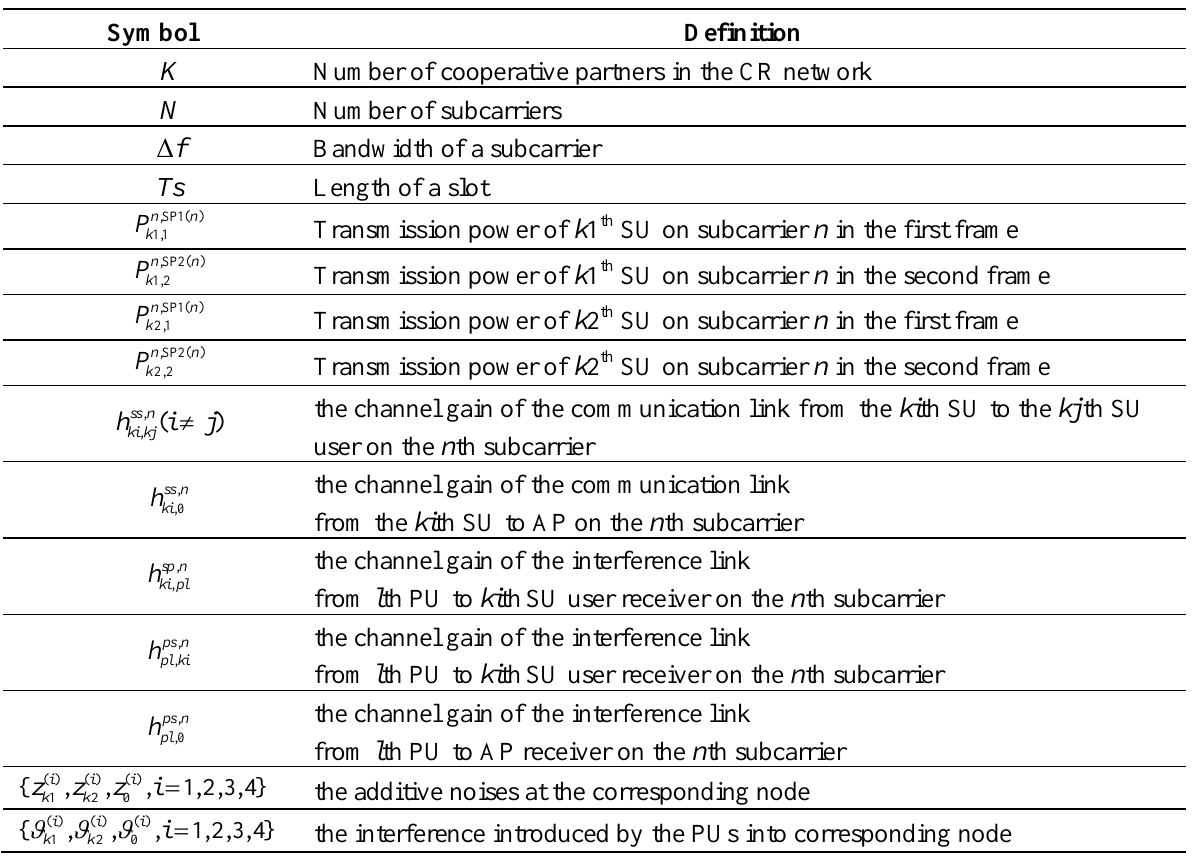
Table 1. Table of